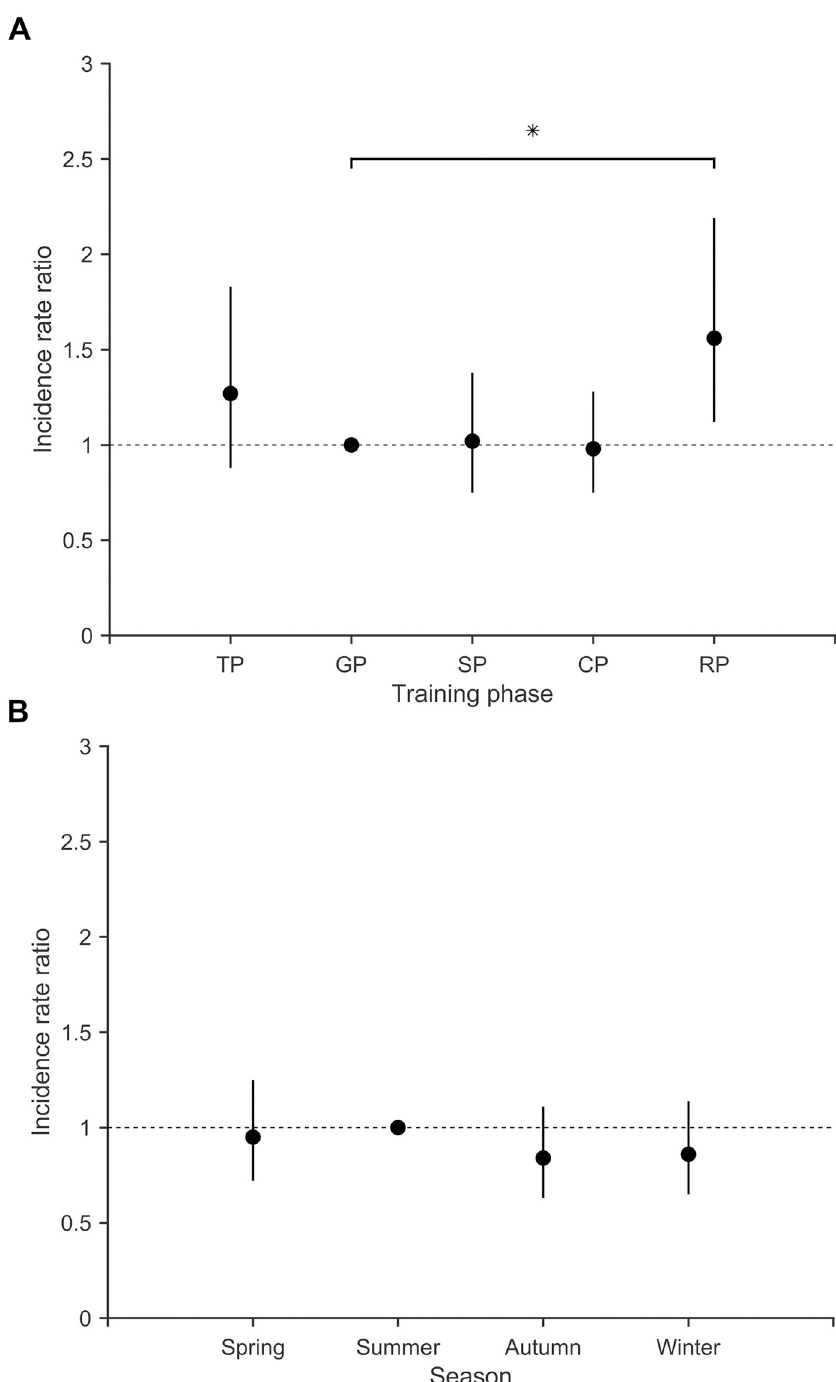
Fig 4. Incidence rate ratios with 95% CIs comparing incidence across training phases and seasons. (A) training phases, comparing the specific preparation (SP), competition (CP), regeneration (RP) and transition phase (TP) to the general preparation phase (GP, referent category), and (B) seasons, comparing the spring, autumn and winter to the summer (referent category). � significantly different from the respective referent category (p < .05).